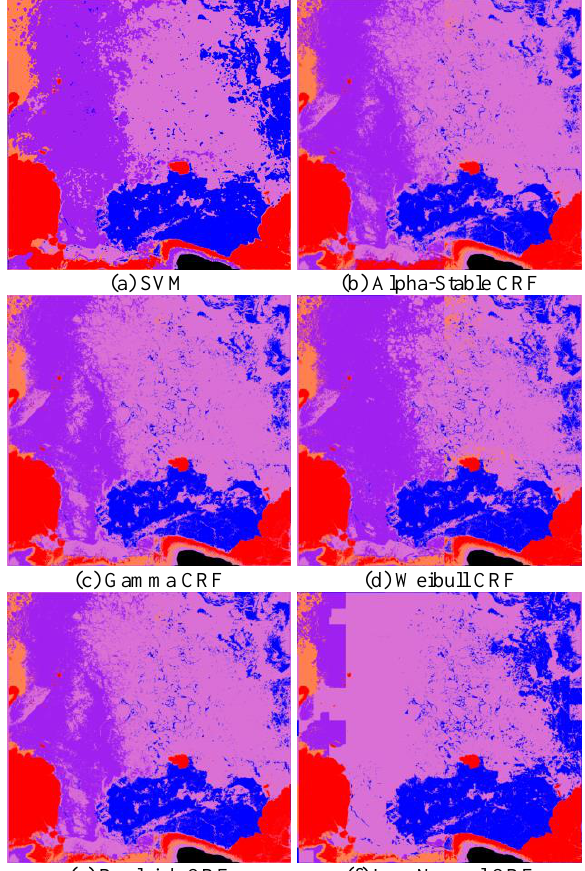
Figure 4. Sea ice classification result in Prydz Bay area